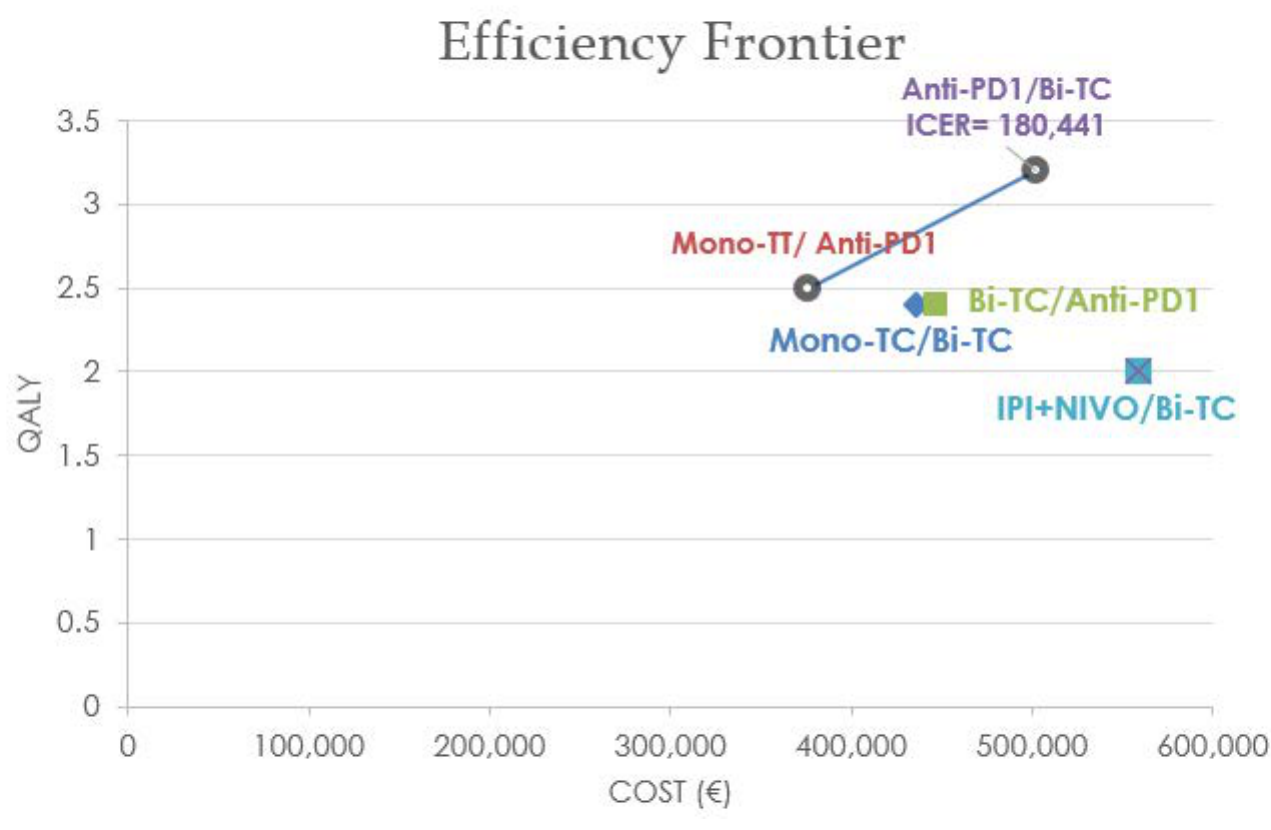
Figure 2. Efficiency frontier for the BRAF-mutated